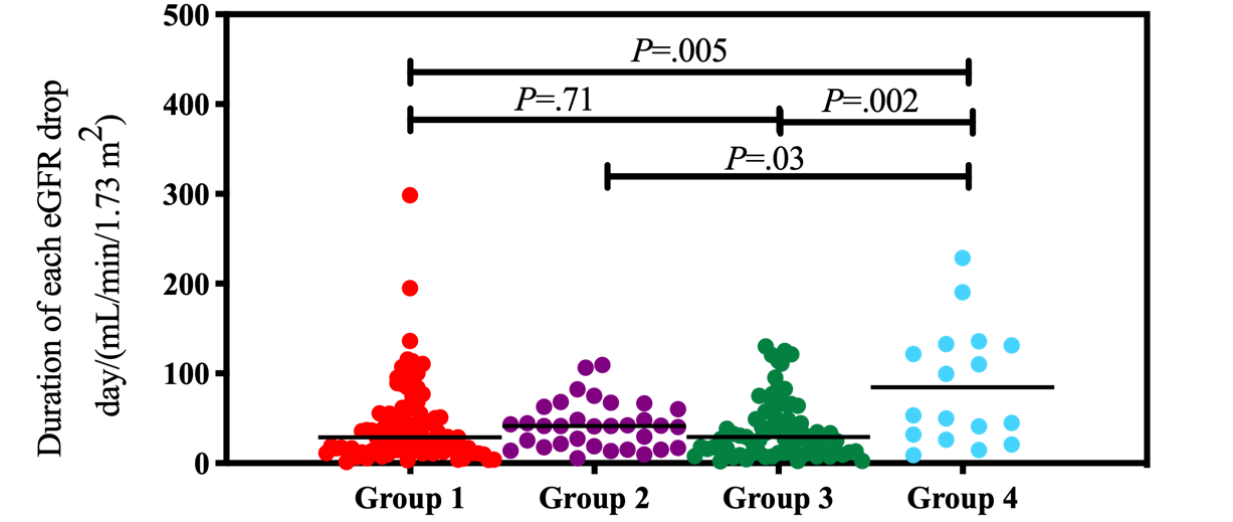
Figure 3. Durations of each drop in estimated glomerular filtration rate (EGFR; day/[mL/min/1.73 m 2 ]) were compared between the four groups. The lines indicate median values. Statistical calculation of P values was performed using the nonparametric Mann-Whitney U